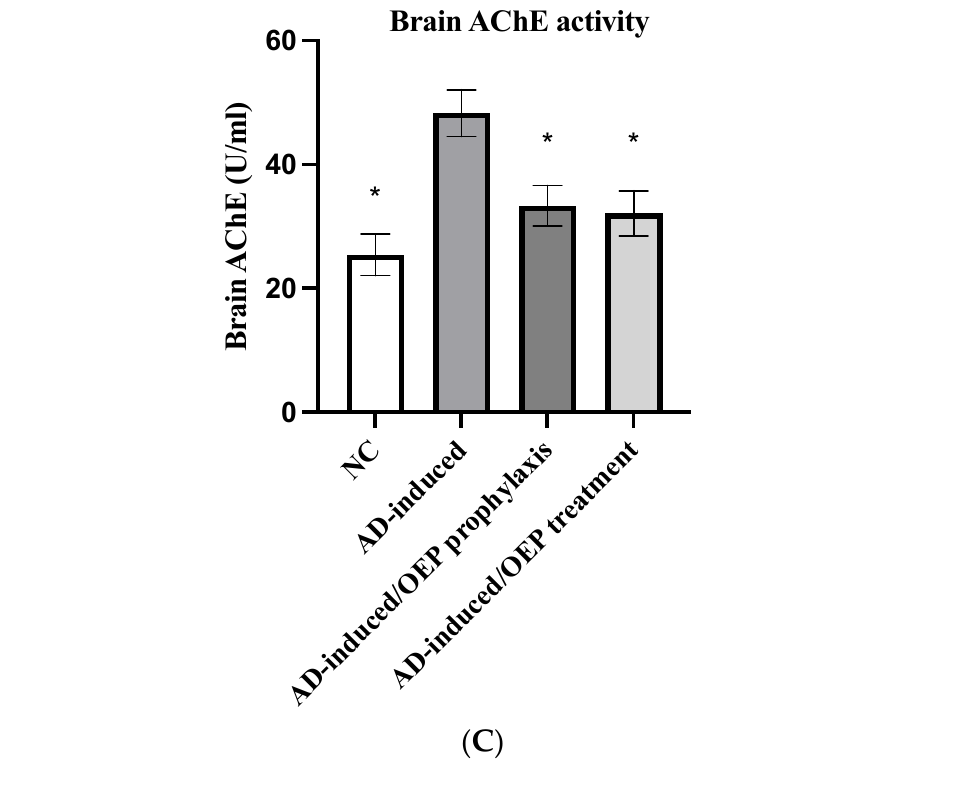
Figure 11. Prophylactic and therapeutic effects of OEP extract on total TAC, serum AChE activity, and brain AChE activity in different groups. ( A ) Serum levels of TAC. ( B ) Serum levels of AChE activity. ( C ) brain levels of AChE activity. Data represent the mean ± SD ( n = 8). Significant difference was analyzed by one-way ANOVA, followed by a post hoc Dunnett’s test, where * p < 0.001, compared with the AD-induced group. NC: negative control group; AD: Alzheimer’s disease (AD)–induced rats received AlCl 3 orally at a dose of 17 mg/kg body weight daily for 21 days; TAC: total antioxidant capacity; AChE: acetylcholinesterase; OEP: Olea europaea L. cv. Picual.